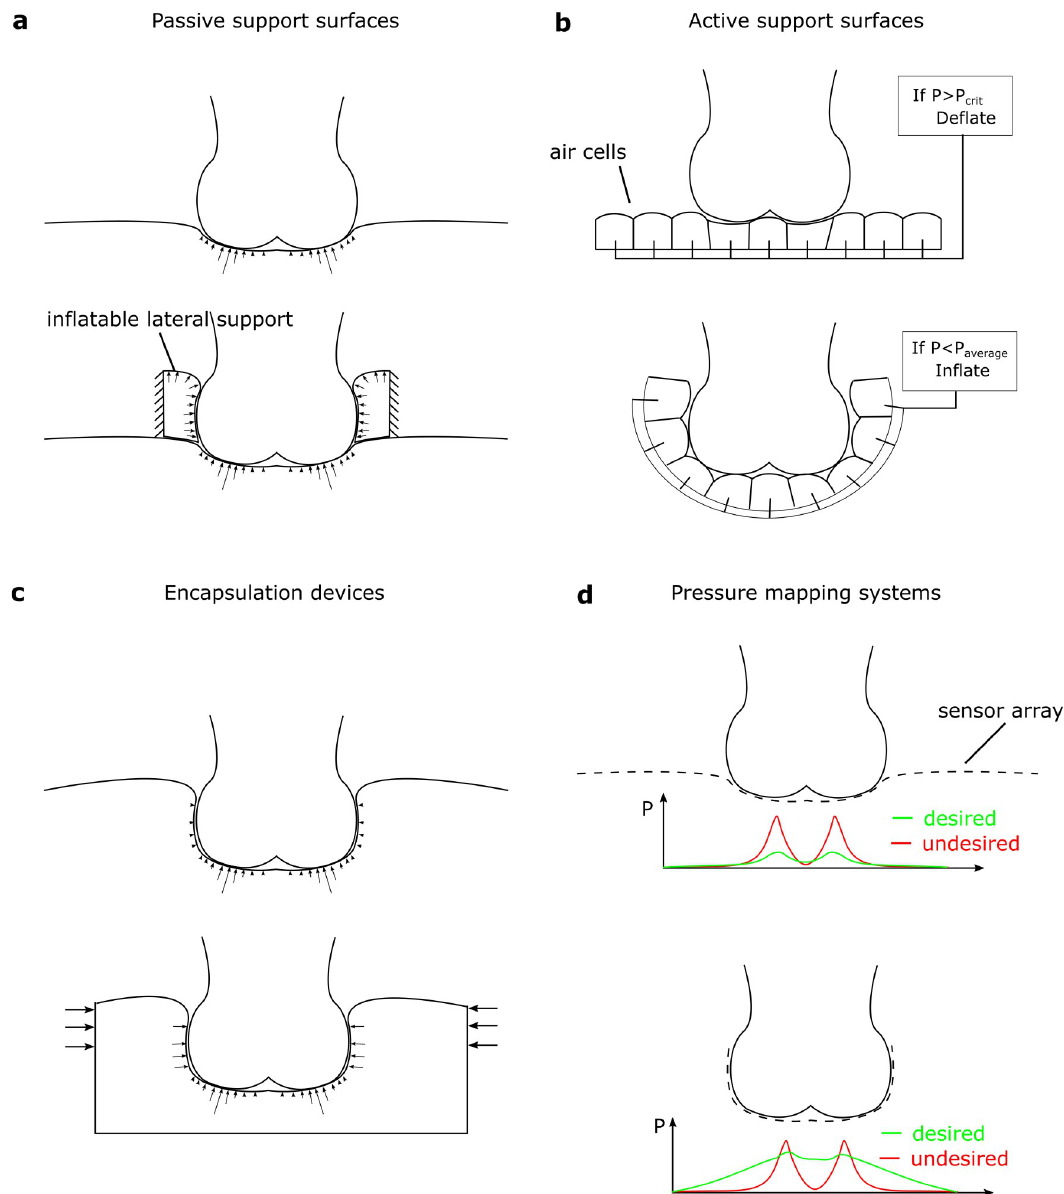
Fig 7. Pressure equalisation and its effects on device design. For surfaces designed to reduce peak pressure passively (a), applying a lateral pressure device helps to avoid lateral bulging (top, showing current devices, bottom showing improved design). Active devices based on individually controlled air cells (b) could be improved by surrounding the soft tissue and changing the control software to aim for equalised pressure, rather than reduce peak pressure. Encapsulation devices achieve large contact areas, but the lateral pressures exerted may be limited (c). These could be improved by active compression or smart materials. Pressure mapping systems (d) currently identify pressure peaks as undesirable. If they could measure pressure around the surface, then they could be re- purposed to measure the level of pressure